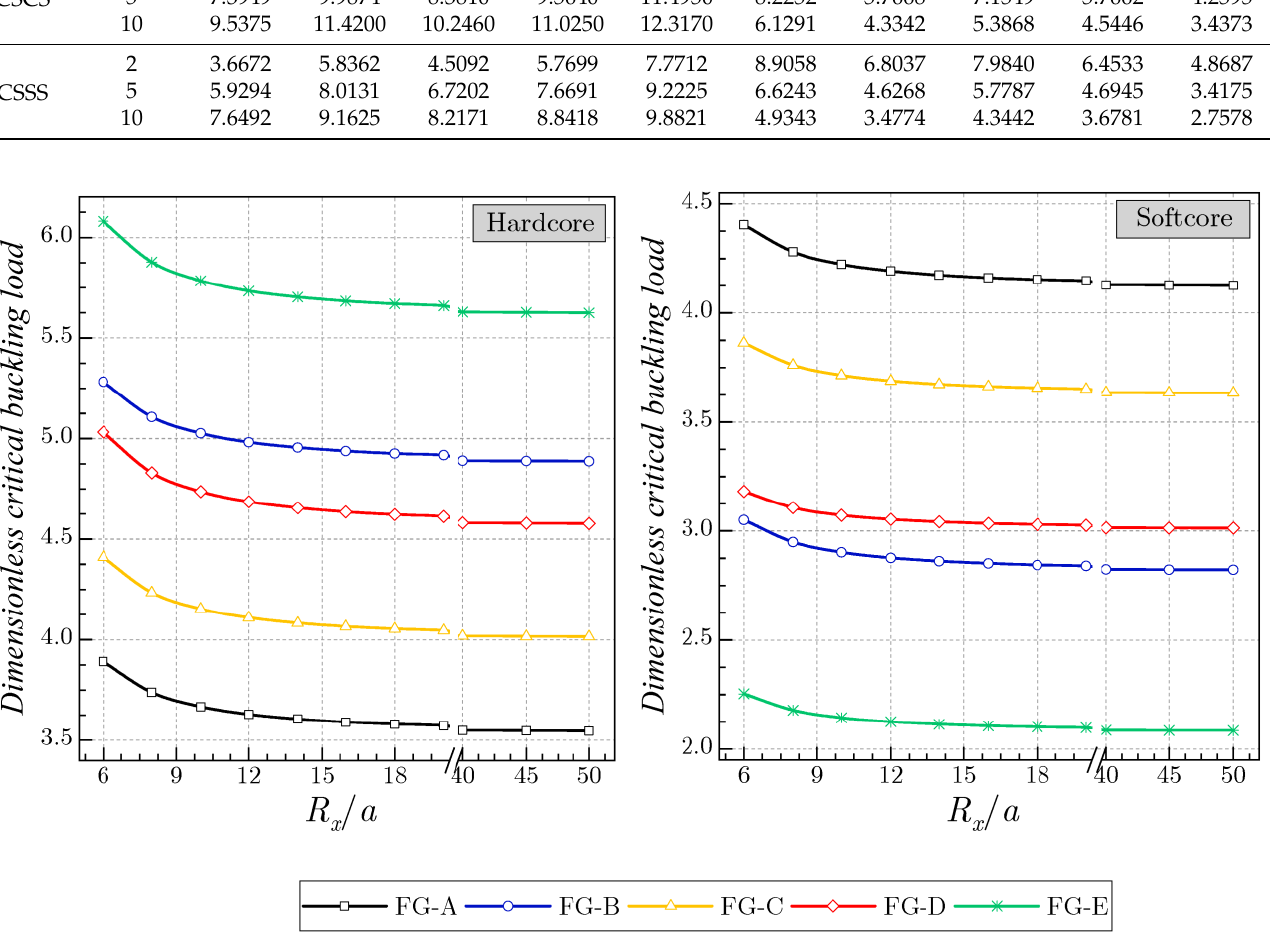
Figure 6. Dimensionless critical buckling load 𝑁̅ of FG shells versus radius of curvature ratio (SSSS , p = 5, b = a = 10 h , µ = λ = G ζ = G η = K w = 0